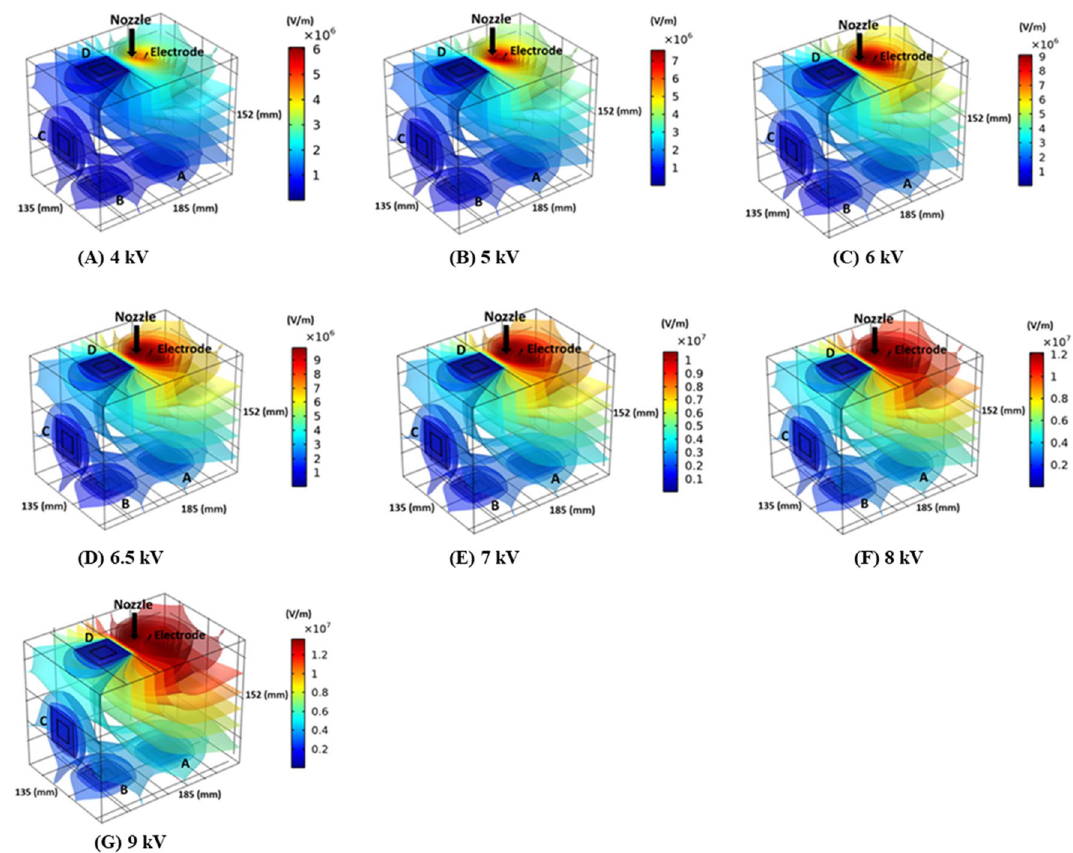
Figure 15. Visualization of the electrostatic field in the box model for ( A ) 4 kV, ( B ) 5 kV, ( C ) 6 kV, ( D ) 6.5 kV, ( E ) 7 kV, ( F ) 8 kV and ( G ) 9